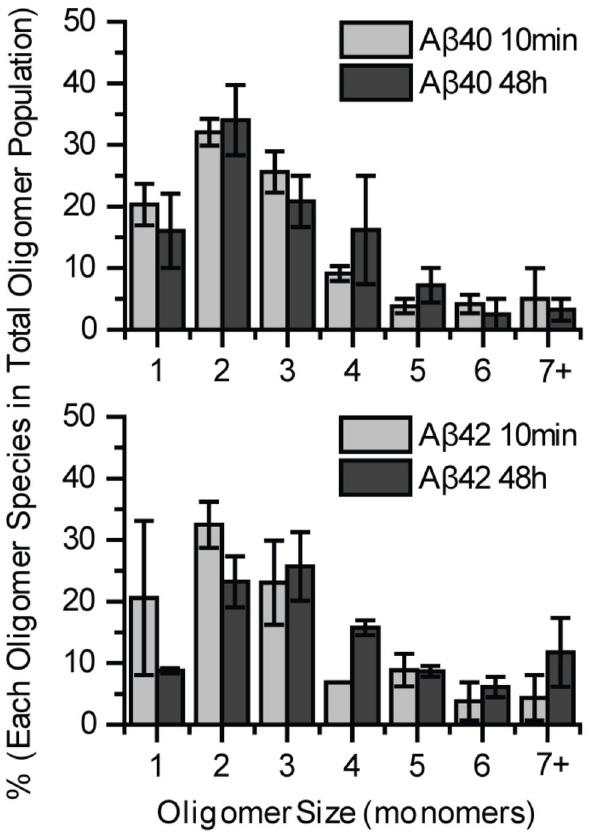
Figure 2. Aβ40 or Aβ42 oligomers form mainly dimers and show little growth on neurites. 2nM Aβ40-HL555 or Aβ42- HL647 was incubated with primary hippocampal neurons for 10 minutes and 48 hours before imaging. Comparison of the oligomeric size distribution between 10 minutes and 48 hours shows limited growth for both Aβ40-HL555 (Mann-Whitney U test, p > 0.1) and Aβ42-HL647 (Mann-Whitney U test, p = 0.001). The distribution is normalized to total Aβ oligomers. different experiments, 5 images each. Each image contained at least 50 oligomers. Error bars represent standard deviation of the mean. The percent is obtained by normalizing to the total number of